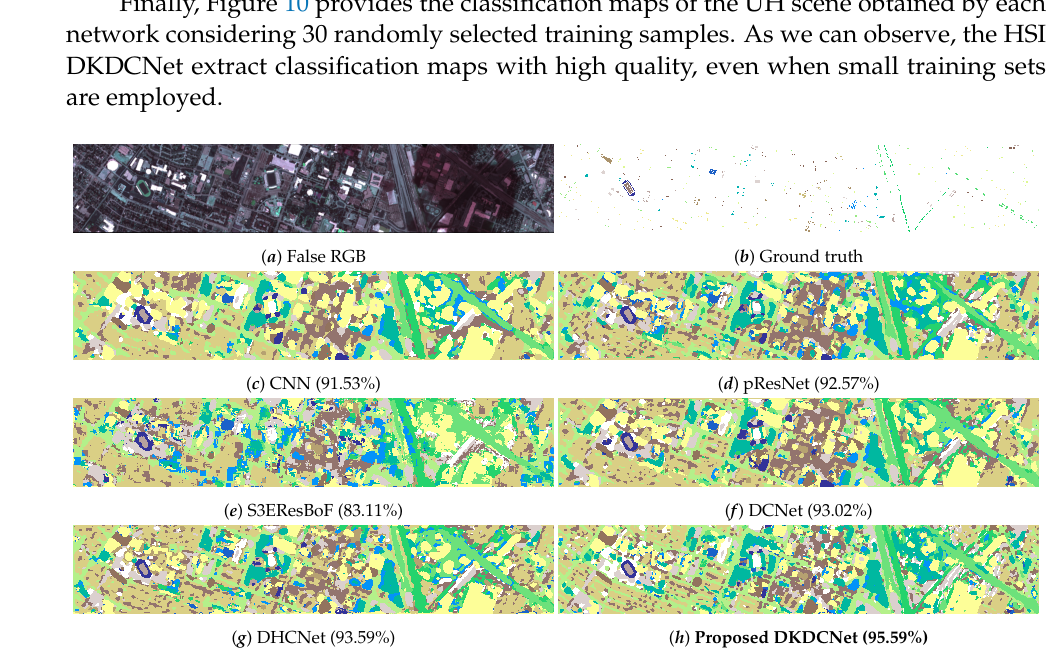
Figure 10. Classification maps obtained from UH scene (considering 30 samples per class). The ob- tained OAs are shown in